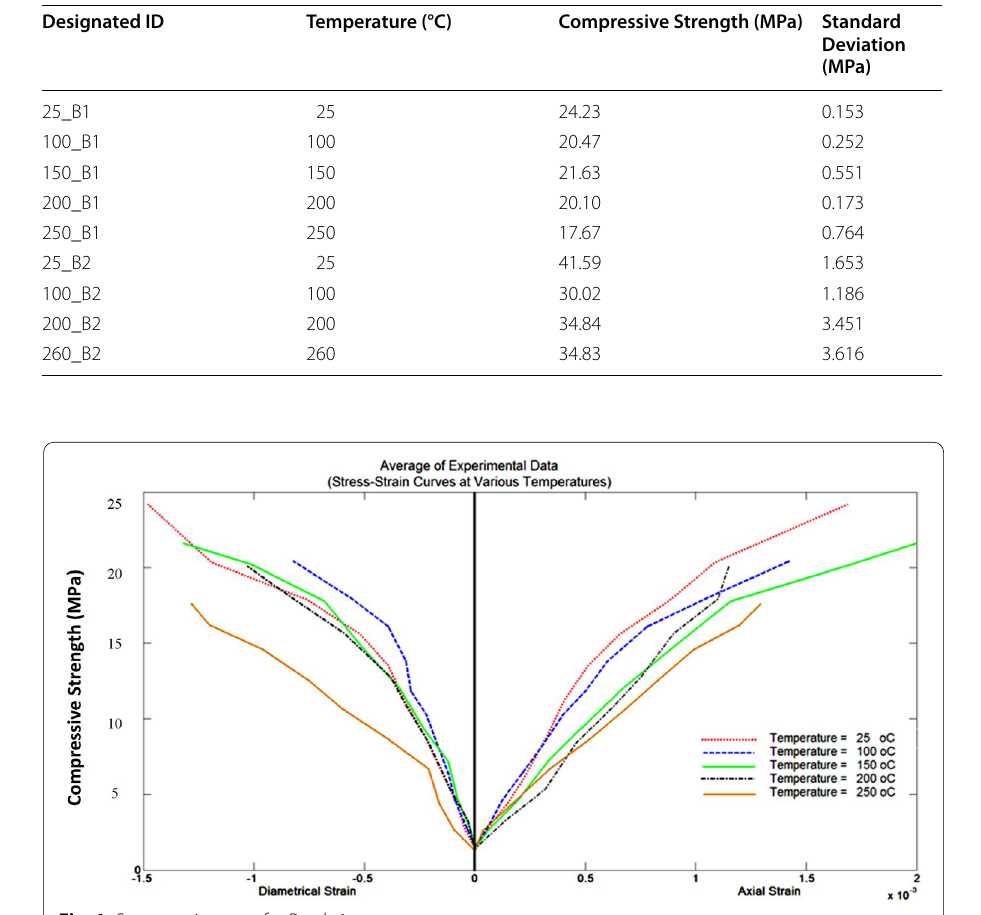
Fig. 1 Stress strain curve for Batch